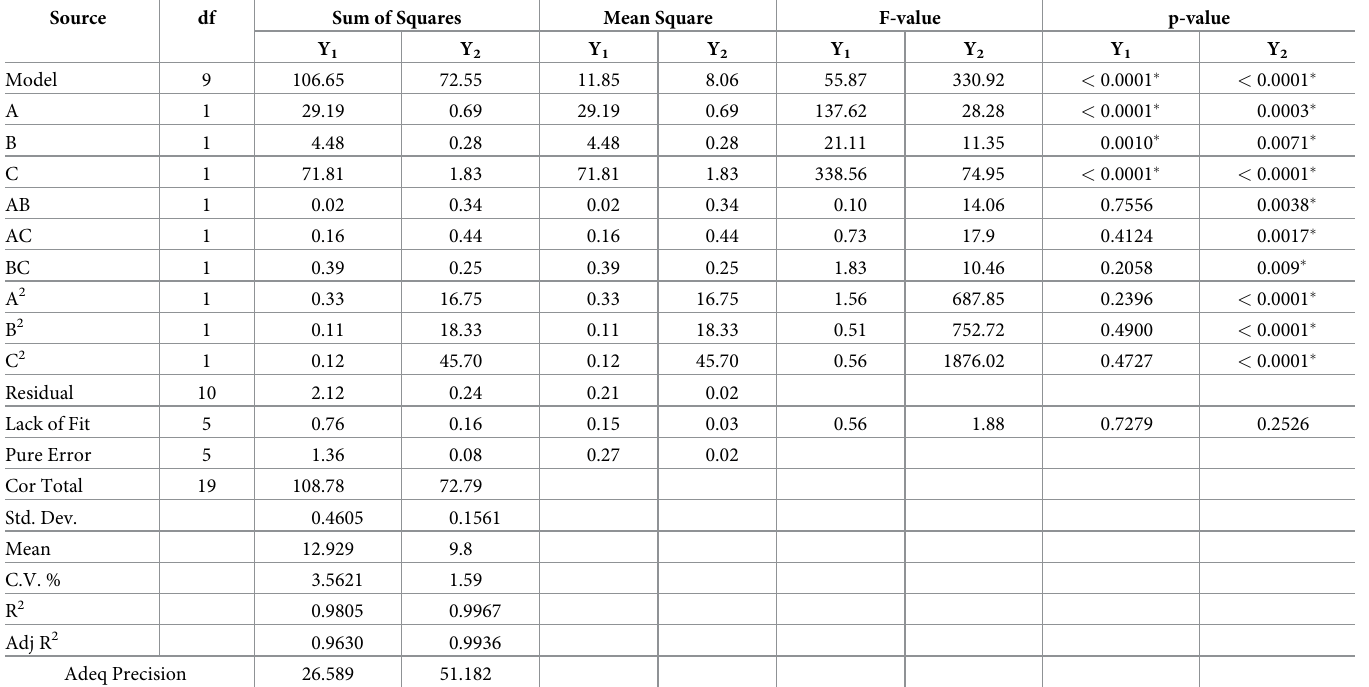
Table 4. ANOVA and estimations of regression coefficients for DH (Y 1 ) and ACE-inhibition (Y 2 ) using the response surface quadratic model. Source df Sum of Squares Mean